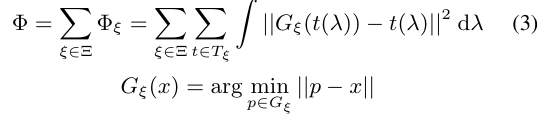
Figure 1. An exemplary street model referenced to { S 1 , S 2 , S 3 } of the road accurate map and an exemplary block spanning from the relative value 0 . 6 to 0 . 8 . The filled bullets mark nodes and the arrows mark edges of the road accurate graph.